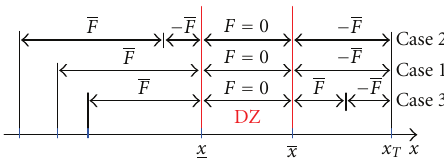
Figure 2: Force planning for 1D